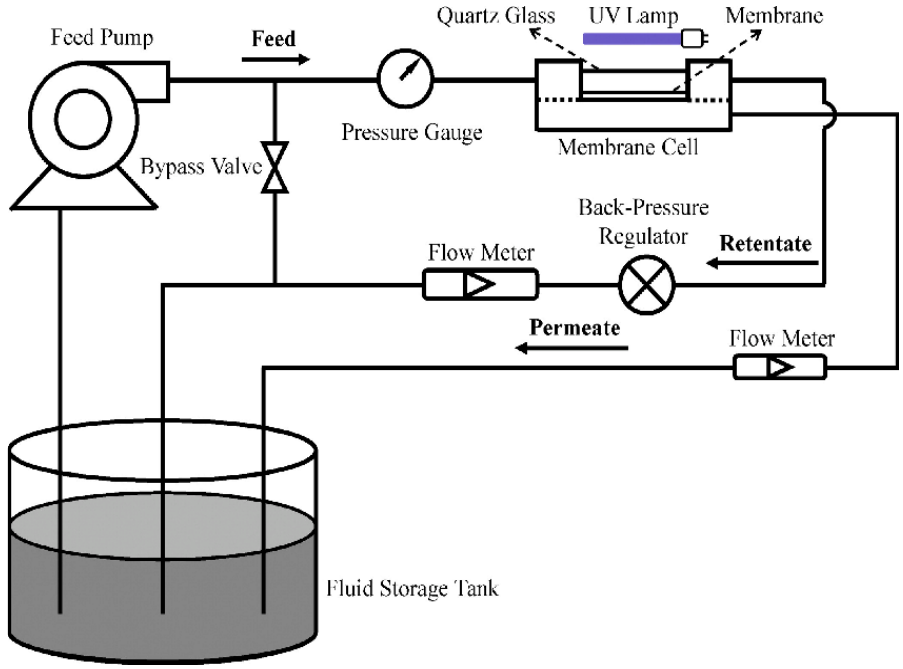
Figure 4. A representation of a PMR operating in crossflow mode. Reproduced with permission from [44], Copyright 2014 Elsevier.